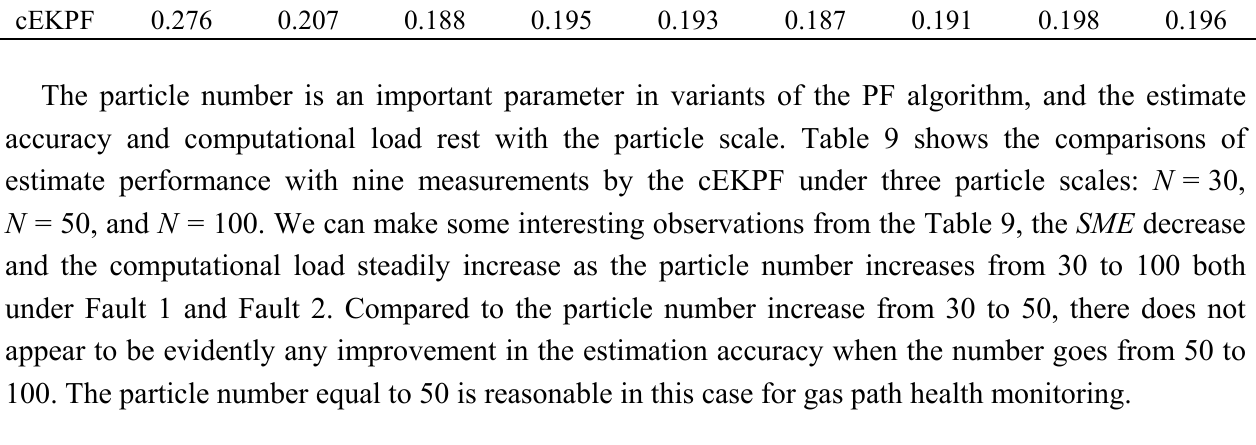
Table 9. Comparisons of estimate performance by the cEKPF under different particle scales. Fault 1 Fault